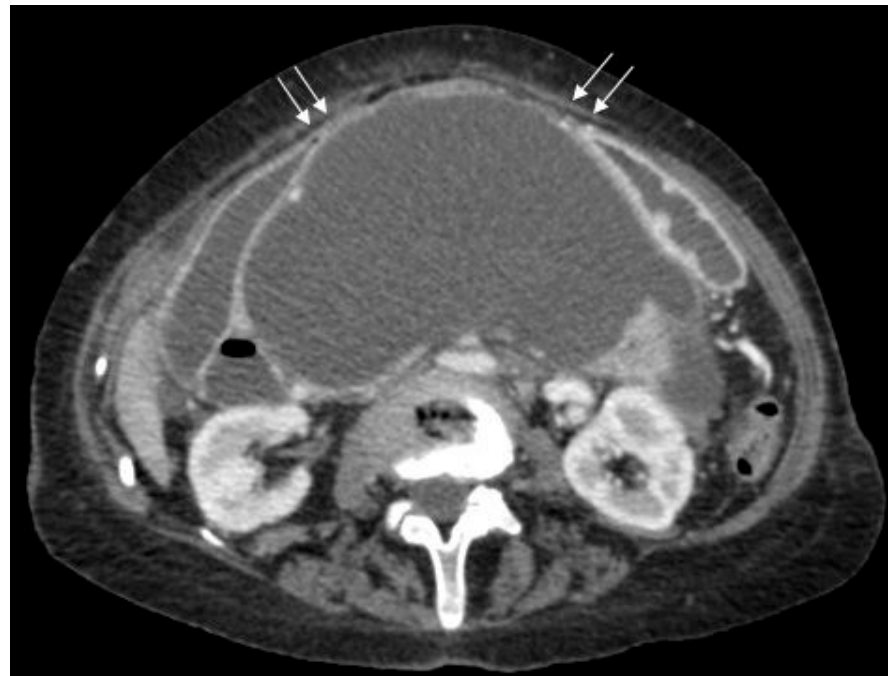
Figure 1. Axial post-contrast computed tomography (CT) scan of the upper abdomen showing a large pancreatic pseudocyst with the stomach (arrows) stretched anteriorly over it.